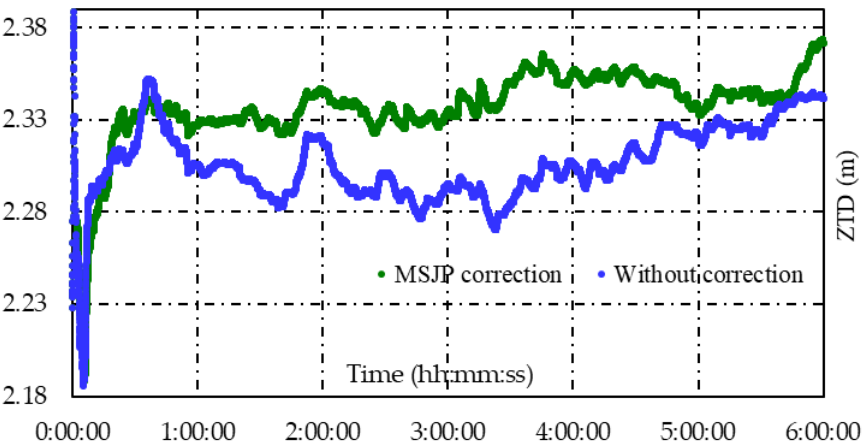
Figure 21. Coordinate biases from static PPP with MSJP correction.